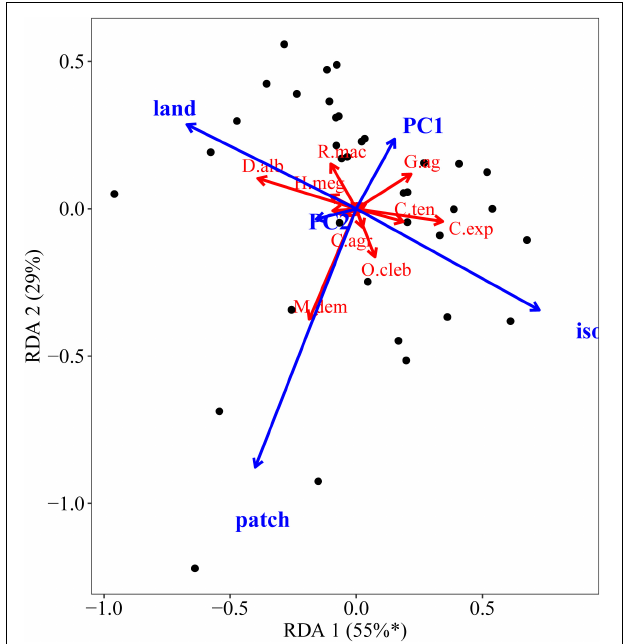
FIGURE 4 | RDA triplot (Scaling 2 method – correlation plot) showing the relationship between small mammal species composition, landscape structure [patch area (patch), patch isolation (iso), and proportion of habitat amount in the landscape (land)], and habitat quality (PC1 and PC2 corresponding to the first and second axis of a principal component analysis of six forest structure variables used to describe habitat quality) in semideciduous forest patches in the Brazilian Cerrado. Species are shown in red: Calomys expulsus (C.exp), C. tener (C.ten), Cryptonanus agricolai (C.agr), Didelphis albiventris (D.alb), Gracilinanus agilis (G.ag), Hylaeamys megacephalus (H.mega), Marmosa demerarae (M.dem), O. cleberi (O.cleb), and Rhipidomys macrurus (R.mac). Sampling sites are represented by black